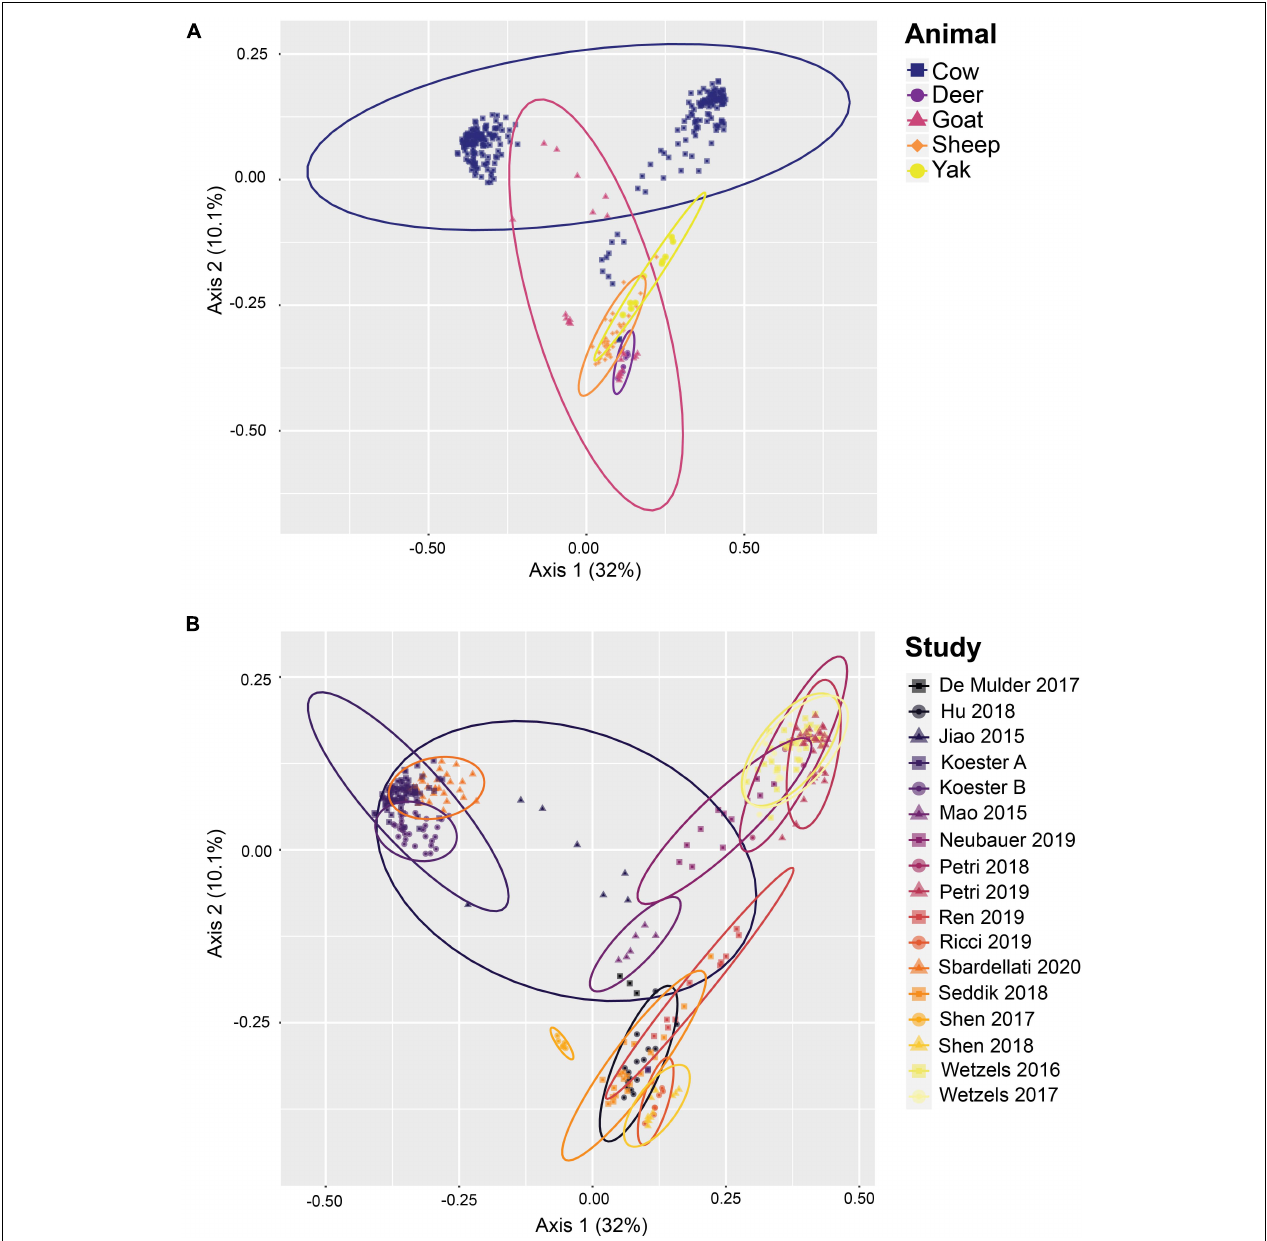
FIGURE 4 | Beta diversity of rumen epithelial microbial communities revealed by principle coordinates analysis based on Bray-Curtis distances after de novo OTU clustering. (A) Samples highlighted by animal, (B) shows samples highlighted by study. See Supplementary Table 1 for more details on the